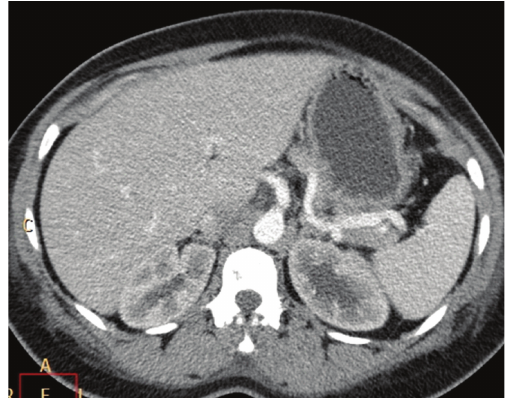
Figure 3: Follow-up CT abdomen after a week shows resolution of gastric